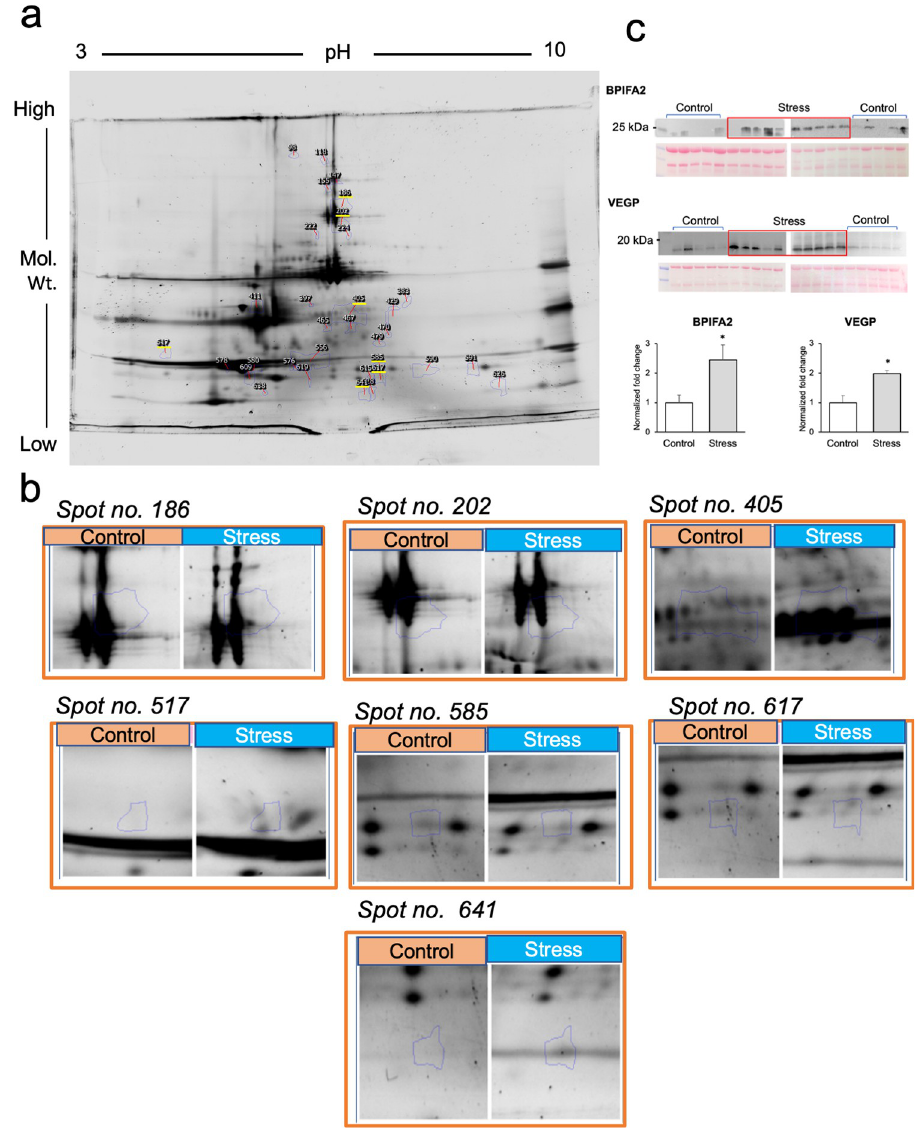
Fig 2. Identification of significantly altered protein spots in the gel and validation by Western blot analysis. The protein spots in each gel after fluorescence staining were identified using the LuminoGraph I and ImageSaver 6 software and quantified with the Progenesis SameSpot software. Eight gels from each group were used for quantification. (a) A representative gel image showing the protein spots. The spots underlined in yellow were visible after silver staining and were selected for mass spectrometry. (b) The magnified image of the protein spots was subjected to mass spectrometry. (c) The levels of two candidate proteins, BPI fold-containing family A member 2 (BPIFA2) and von Ebner’s gland protein (VEGP) were confirmed in all samples via Western blotting. The mean intensities of the bands were significantly higher in the stress group compared to those in the controls ( � p < 0.05; Mann Whitney-U